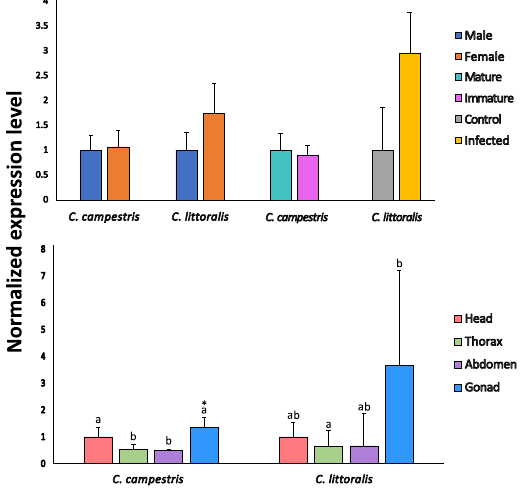
Figure 7. Relative expression of Clit-Def gene (control and infected samples) and UBC9 gene (rest of the samples) using the reference genes selected for each condition in both species of tiger beetles. Male, mature, control and head samples are used as normalizer for each experiment. Error bars represent the Standard Error for the Normalized Relative Quantity. Letters are indicating significant differences with a p value < 0.05, while asterisks indicate p values <